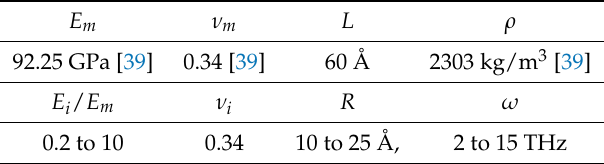
Table 1. List of Parameters and Reference